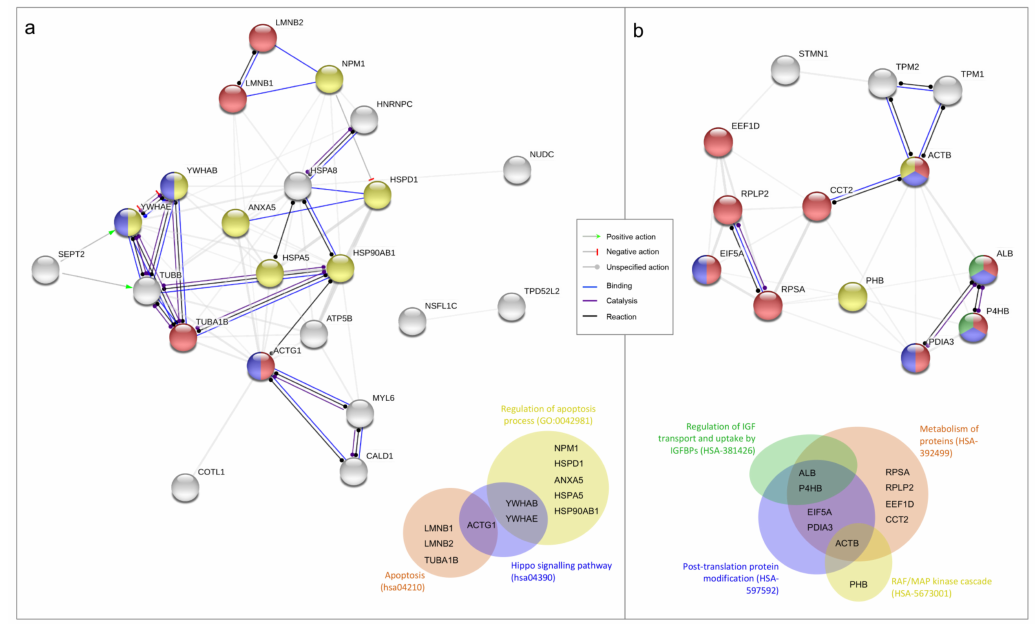
Figure 2. Functional proteins association networks identified by di ff erential proteomic analysis and relative Venn diagrams. Interaction networks identified between under-expressed (panel a ) and overexpressed (panel b ) proteins in T24 cells after 3 days (72 h) of 10 µ M ATRA treatment in comparison to vehicle treatment (DMSO). All the proteins identified by the proteomic analysis are reported; only the actions (lines between nodes) of the selected pathways are highlighted with the colors reported in the figure’s legend. Di ff erent colors of nodes indicate the following di ff erent functional relationships, according to STRING database and referring to Gene Ontology (GO), KEGG Pathway (hsa), and Reactome Pathways (HSA); identifier number is reported in the brackets. Nodes of multiple colors indicate belonging to multiple pathways. Venn diagrams summarize the a ffi liation of proteins to di ff erent molecular pathways. ( a ) Yellow nodes: regulation of apoptosis process (GO:0042981); red nodes: apoptosis (hsa04210); blue nodes: hippo signaling pathway (hsa04390). ( b ) Red nodes: metabolism of proteins (HSA-392499); blue nodes: post-translation protein modification (HSA-597592); green nodes: regulation of insulin-like growth factor (IGF) transport and uptake by insulin-like growth factor binding proteins (IGFBPs) (HSA-381426); yellow nodes: RAF / MAP kinase cascade